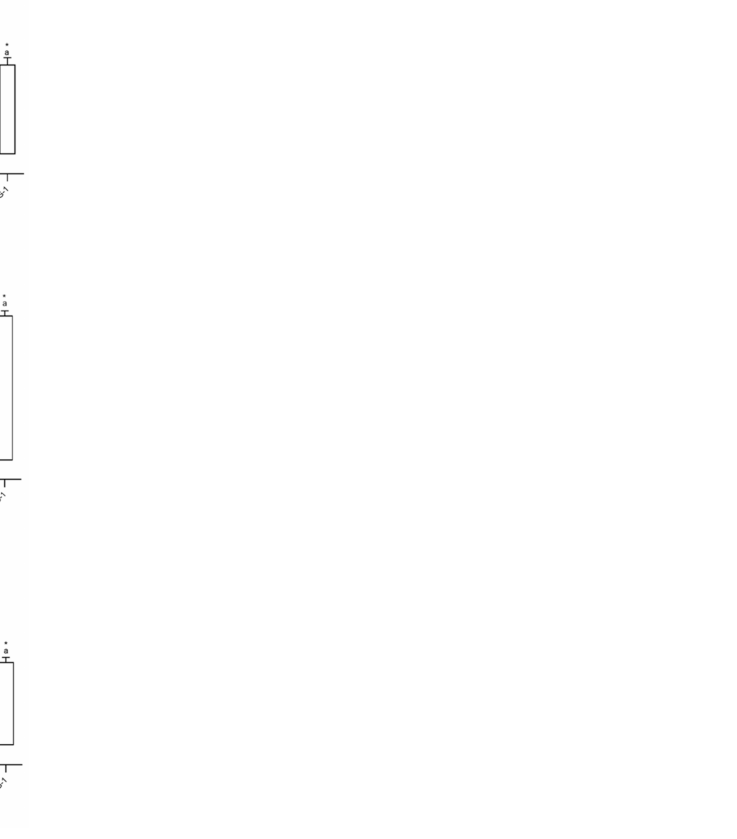
Figure 2. Retinal thickness (upper panel), percentage of retinal area covered by cells (middle panel), and percentage of retinal area covered by extracellular material (lower panel) in retinas from non- diabetic control rats (NDR); two-month follow-up diabetic rats (DR); and DR treated with hydroxyty- rosol 5 mg/kg/day (HT-5), 3,4-dihydroxyphenyglycol 0.5 or 1 mg/kg/day (DHPG-0.5 or DHPG-1), HT-5 plus DHPG-0.5, or DHPG-1, p.o. for two months. n = 10 rats per group. + p < 0.05 with respect to NDR. * p < 0.05 with respect to DR. a p < 0.05 with respect to DHPG-0.5 and DHPG-1. b p < 0.05 with respect to